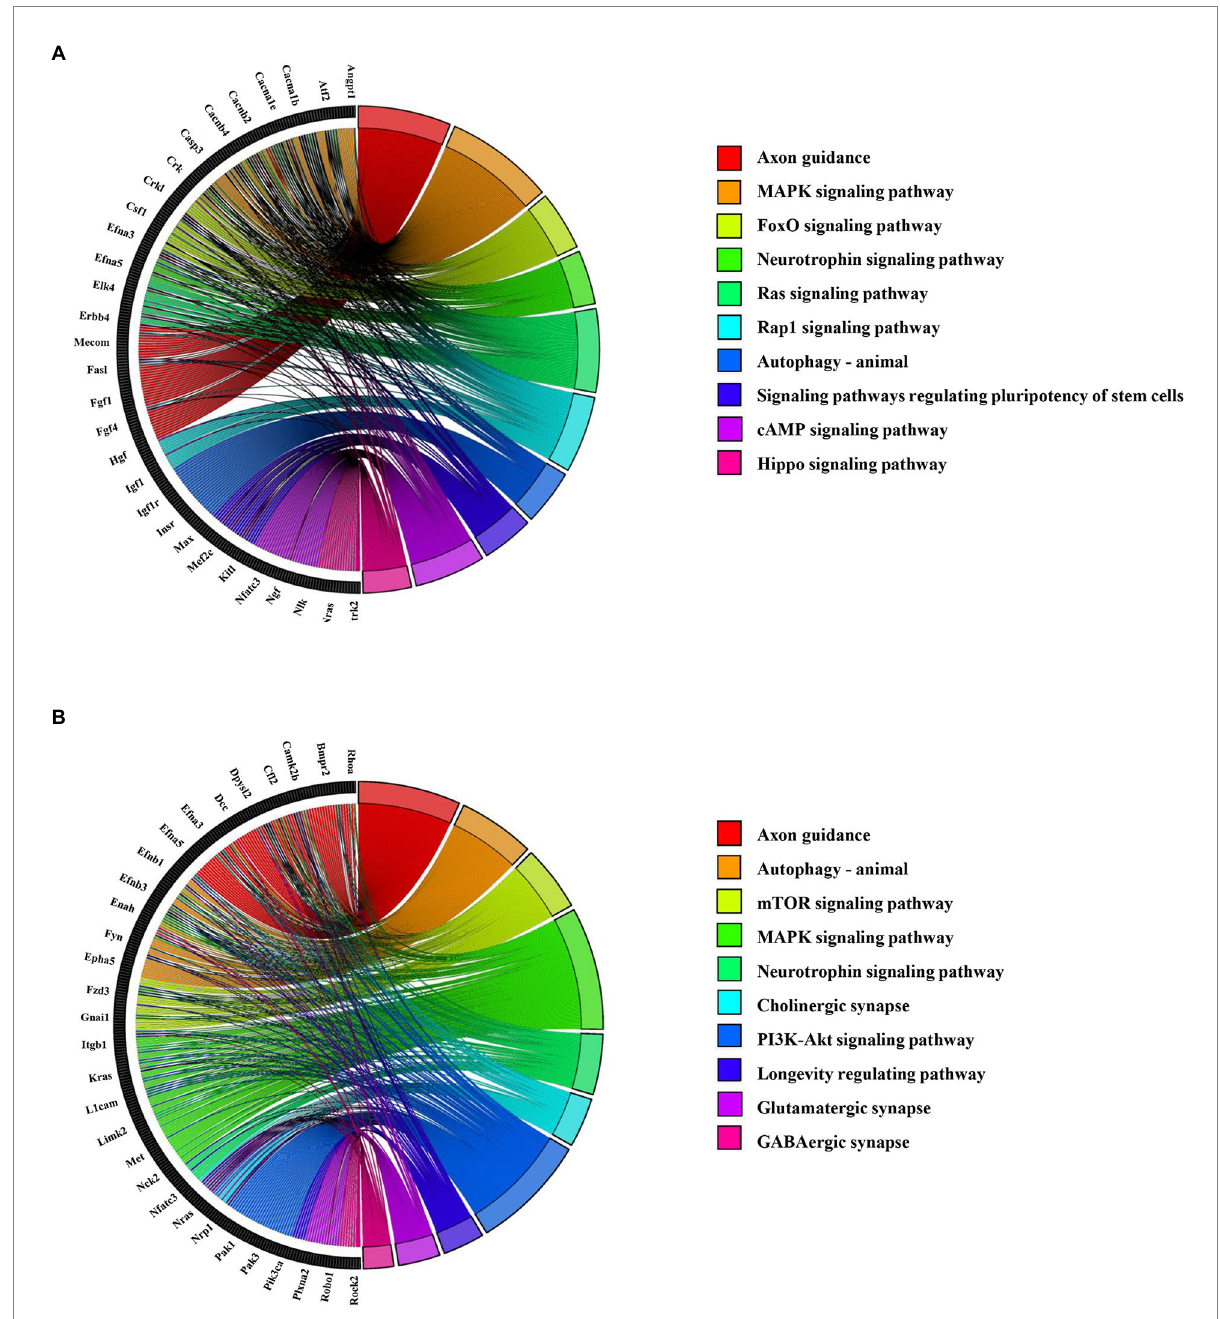
FIGURE 6 Top 10 KEGG enrichment pathways for the abnormally expressed circRNAs. (A) KEGG pathways for upregulated circRNA-related mRNAs. The left section shows the circRNA-related mRNA name, and the right section shows the top 10 pathways. (B) KEGG pathways for downregulated circRNA-related mRNAs. The left section shows the circRNA-related mRNAs, and the right section shows the top 10 KEGG